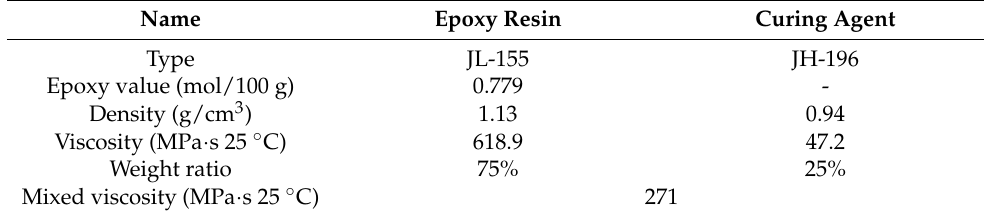
Table 2. Model of